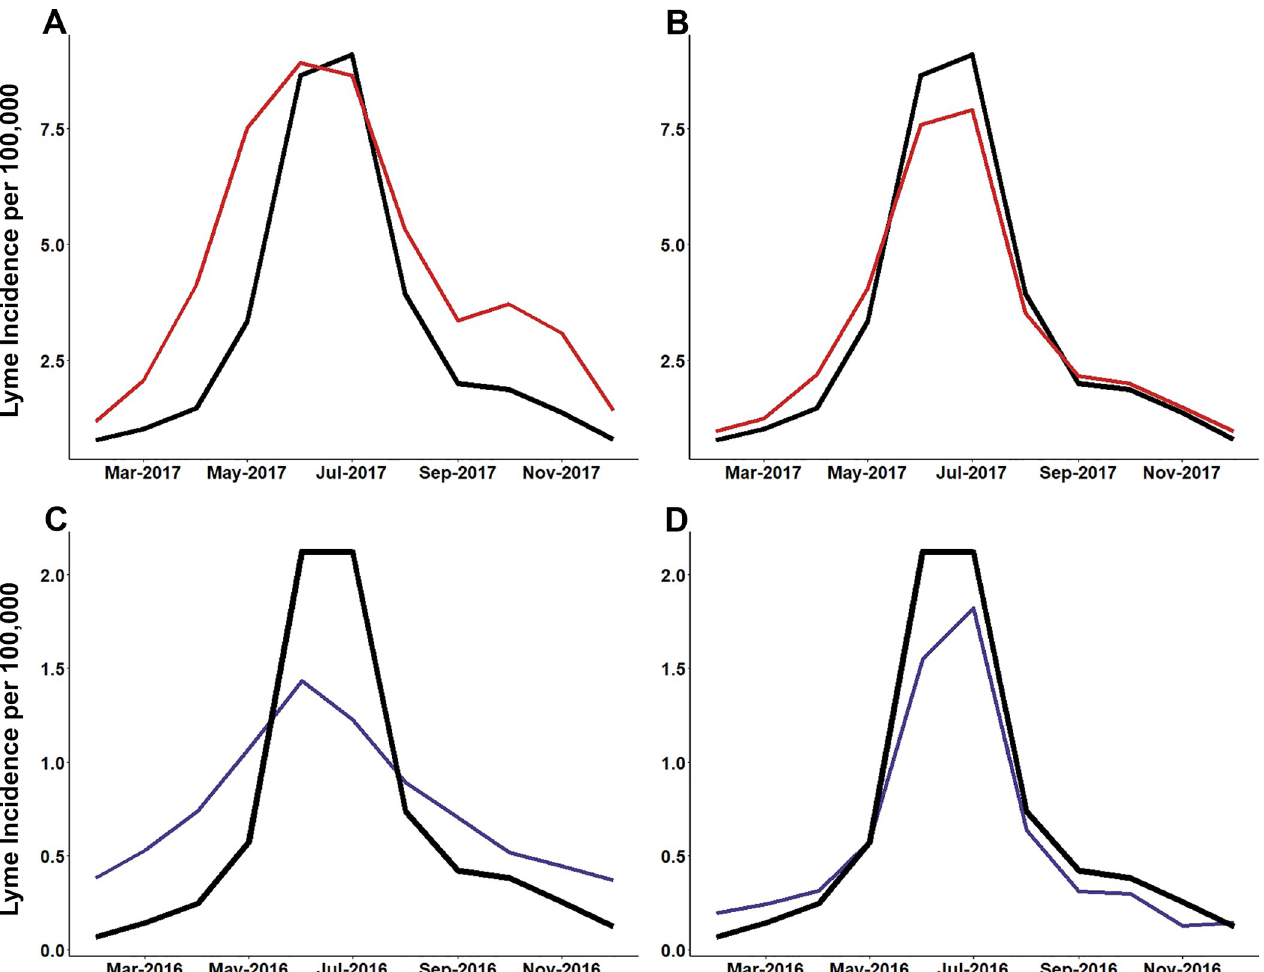
Fig 7. Elastic net modeling using full-term list is sensitive to secondary spikes of Lyme disease incidence in Northeast and Midwest regions. (A) Northeast Lyme disease incidence (black line) and disease symptom and vector terms only model predictions (red line), (B) Northeast Lyme disease incidence (black line) and full-term list model predictions (red line), (C) Midwest Lyme disease incidence (black line) and disease symptom and vector terms only model predictions (purple line), and (D) Midwest Lyme disease incidence (black line) and full-term list model predictions (purple line). Elastic net models trained using CDC surveillance data and search term data from February 2004 through December 2014 and hold-out data from January 2015 and December